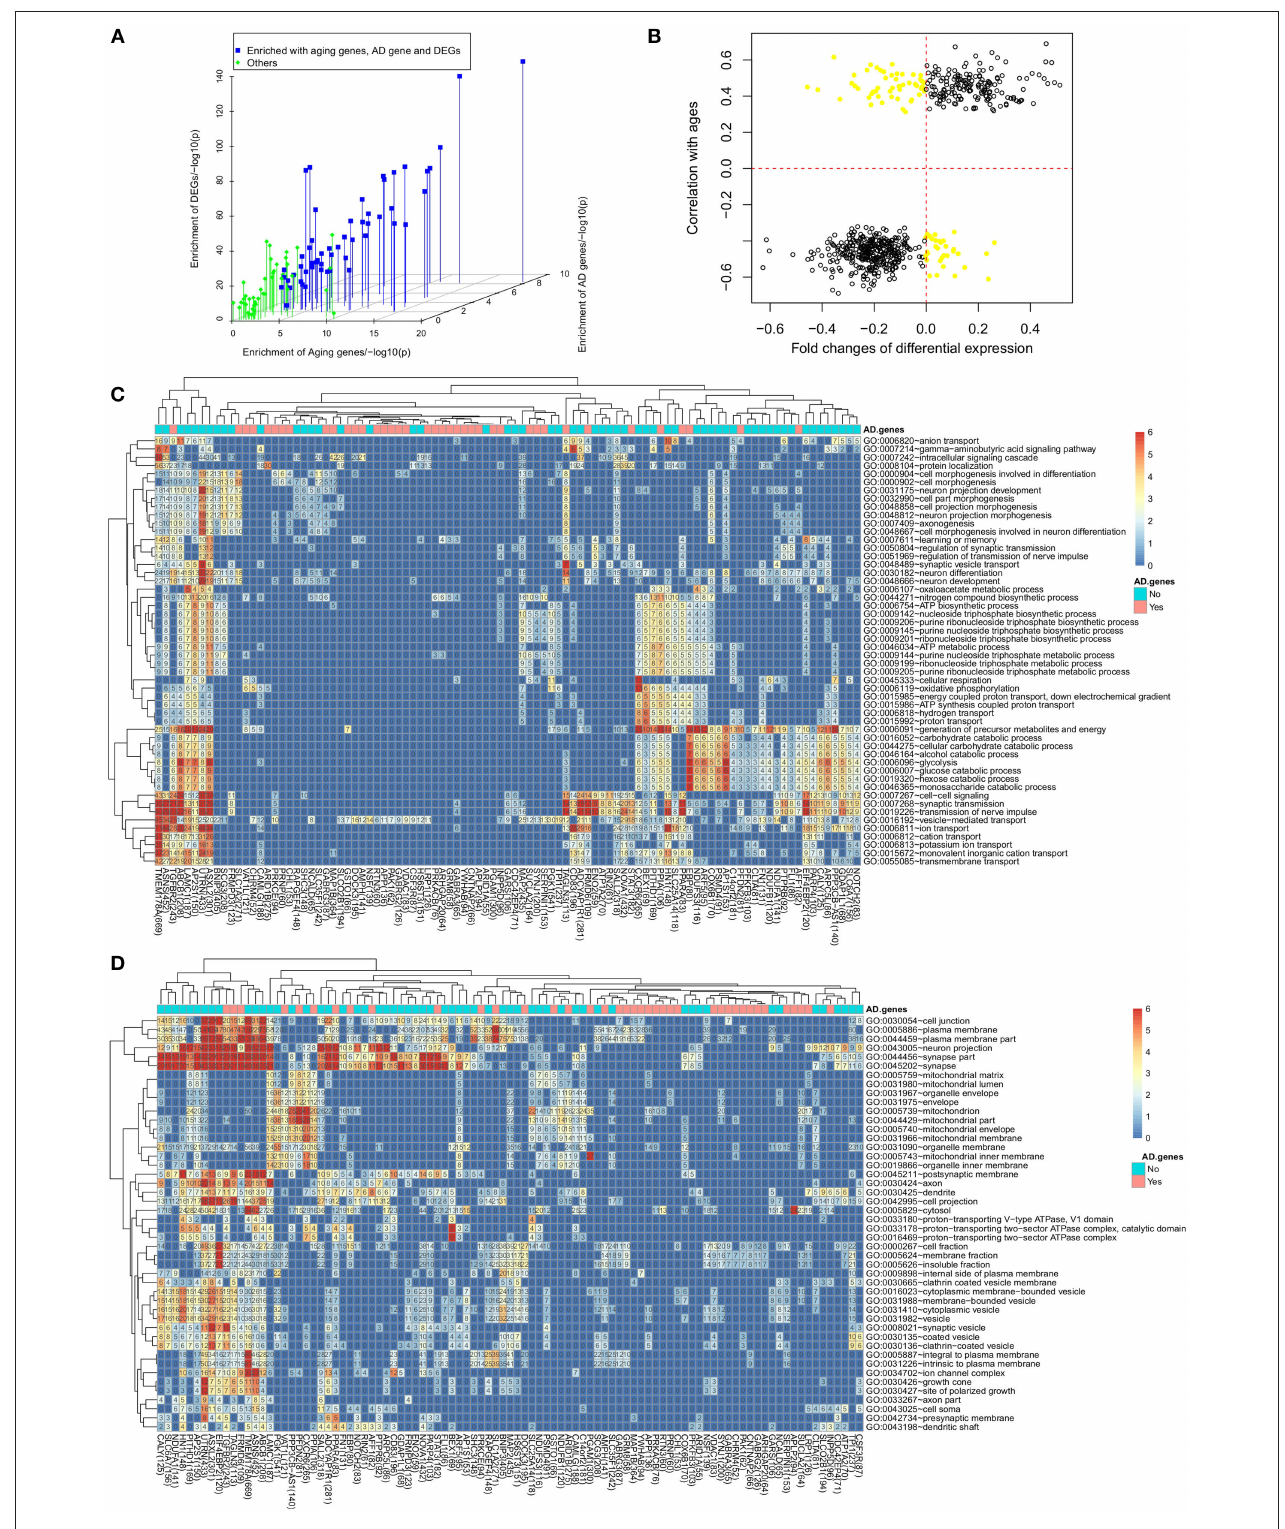
FIGURE 4 | Aging, synaptic transmission and metabolism are dysregulated. (A) The enrichment of aging genes, AD differentially expressed genes and AD related genes in 97 subnetworks; (B) the dysregulated genes usually have the same expression change direction in the aging process and the AD progression; (B) functional enrichment analysis to dysregulated genes for (C) biological process and (D) cellular component.